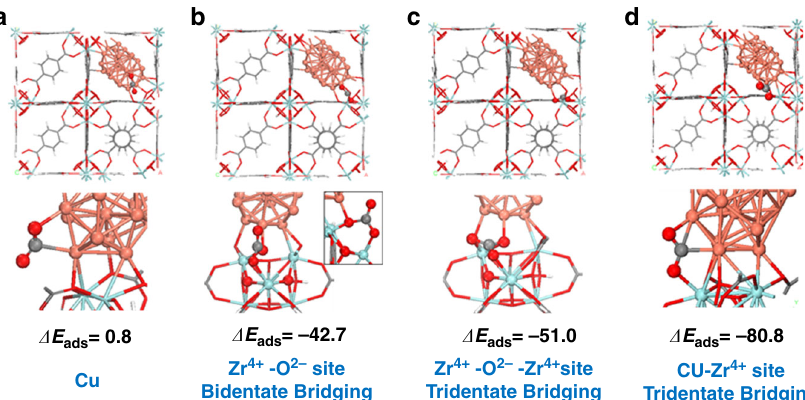
Fig. 5 Adsorption energies ( Δ E ads in kJ/mol) of CO 2 at the Cu/UiO-66-a interface. a Cu only sites, b Zr 4 + -O 2- sites on the Zr 6 O 8 nodes in a bidentate bridging mode, c Zr 4 + -O 2- - Zr 4 + sites on the Zr 6 O 8 nodes in a tridentate bridging mode, and d Cu-Zr 4 +